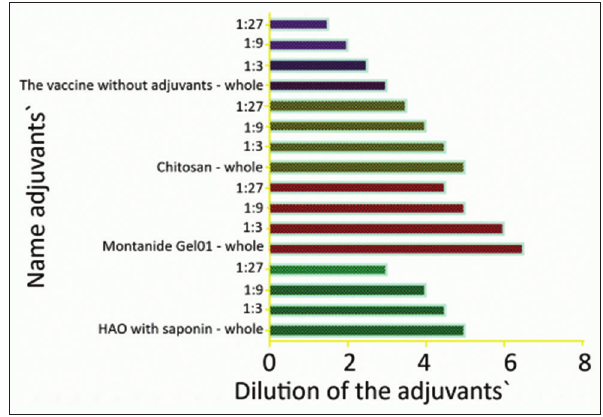
Figure-4: Virus-neutralizing activity titer level in animals vaccinated with an adjuvant